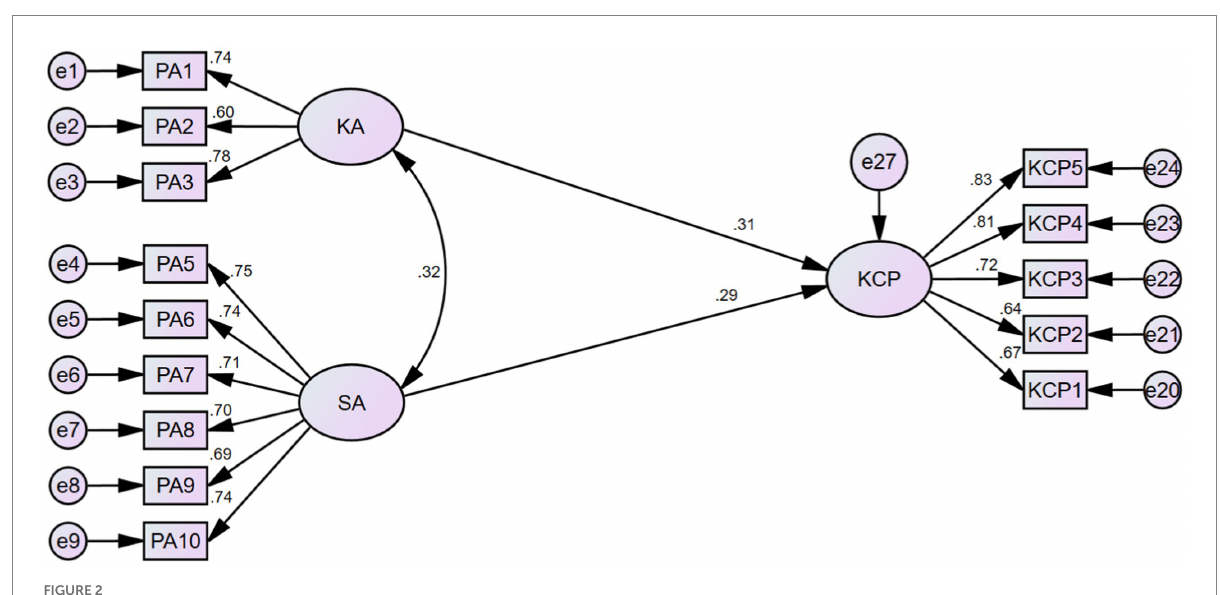
FIGURE 2 Structural equation modeling for the main